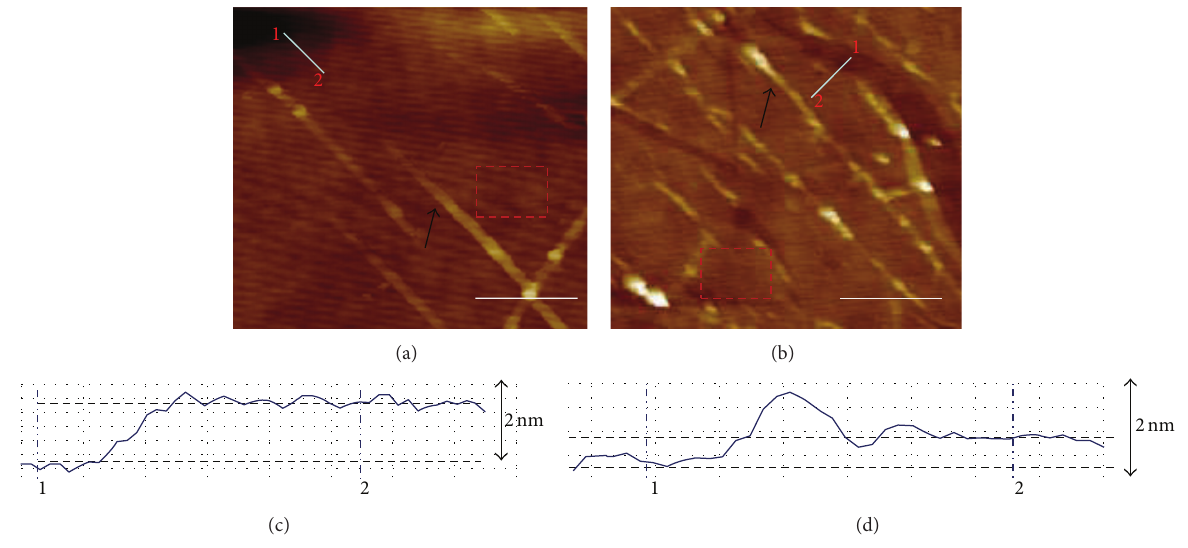
Figure 5: AFM images of the Gr film on Si substrate: (a) before annealing; (b) after thermal annealing at 400 ∘ C. The height profile of the Gr films along the white line starting from where the Gr film is partly broken (point 1): (c) before annealing; (d) after annealing at 400 ∘ C. The root-mean-square (rms) surface roughness is acquired on a scan window highlighted by the red box. The arrows in the AFM images show the corrugation of the Gr film. The scale bars represent 1 𝜇